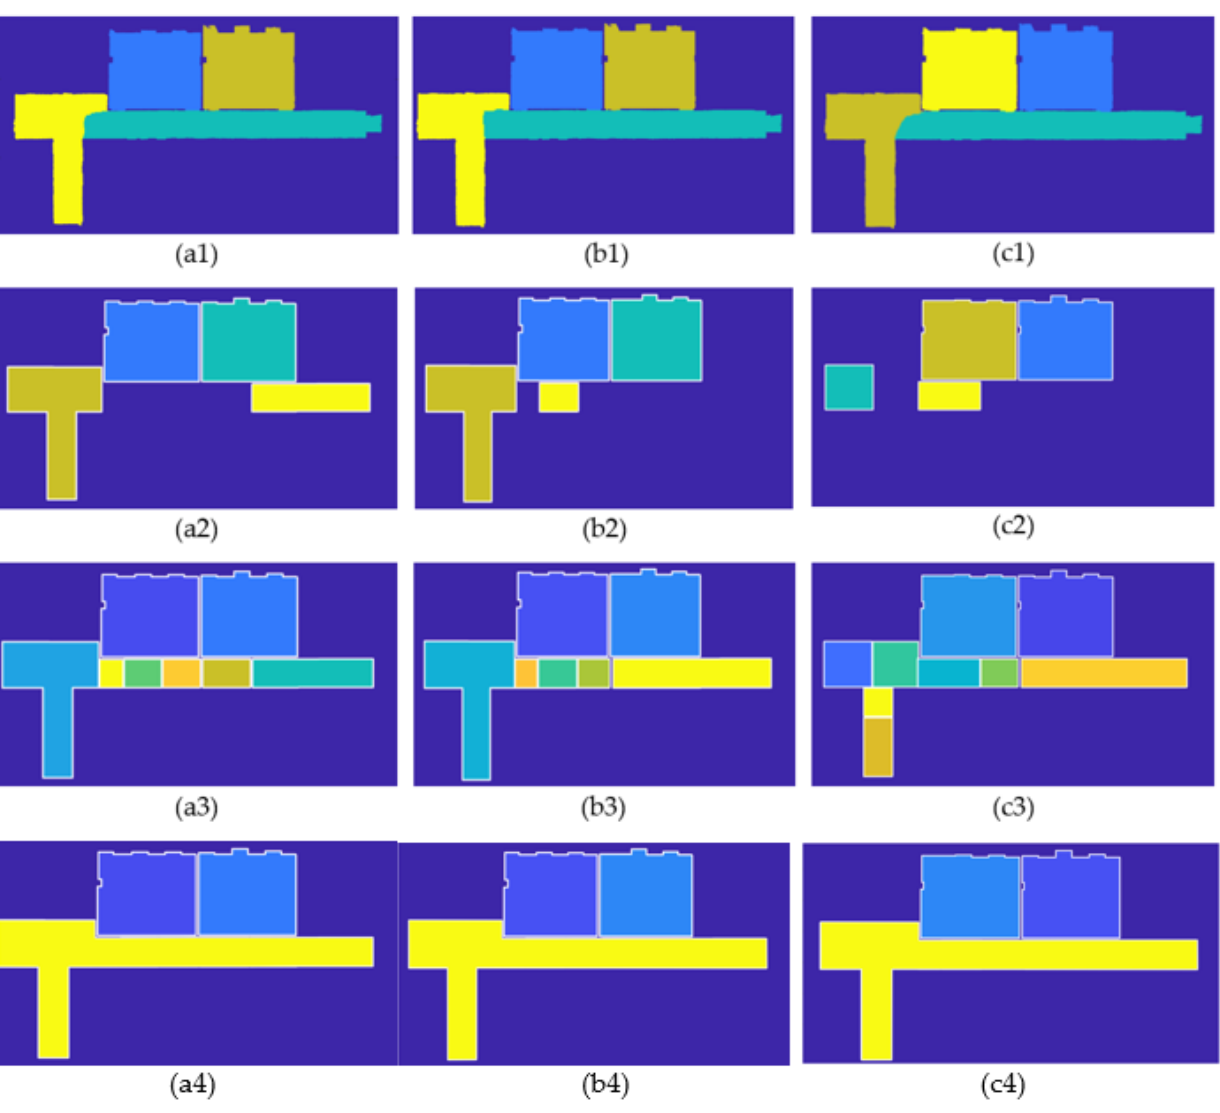
Figure 10. Three rounds (i.e., a, b, c) of the realisations of the grammar rules: ( a1 , b1 , c1 ) represent the segmented 2D indoor areas (i.e., room candidates) in each round, ( a2 , b2 , c2 ) represent the initial boundaries of the 2D room candidates in each round, ( a3 , b3 , c3 ) represent initial and additional boundaries of the 2D room candidates in each round, ( a4 , b4 , c4 ) represent the final boundary after the connection analysis in each round.